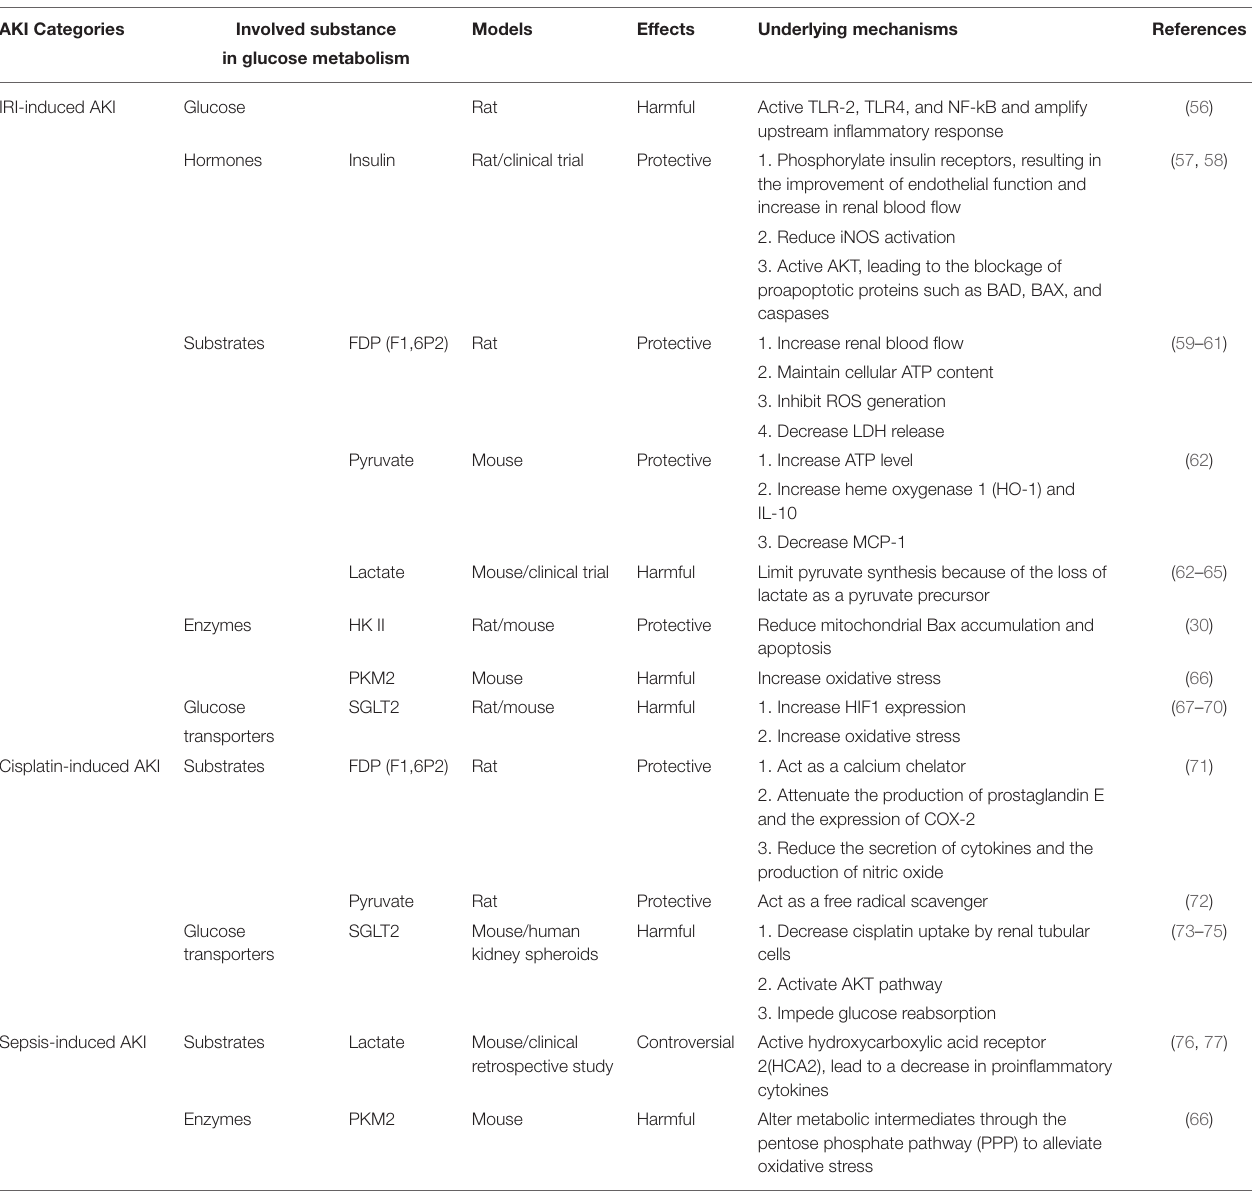
TABLE 1 | Summary of the studies of glucose metabolism in acute kidney injury